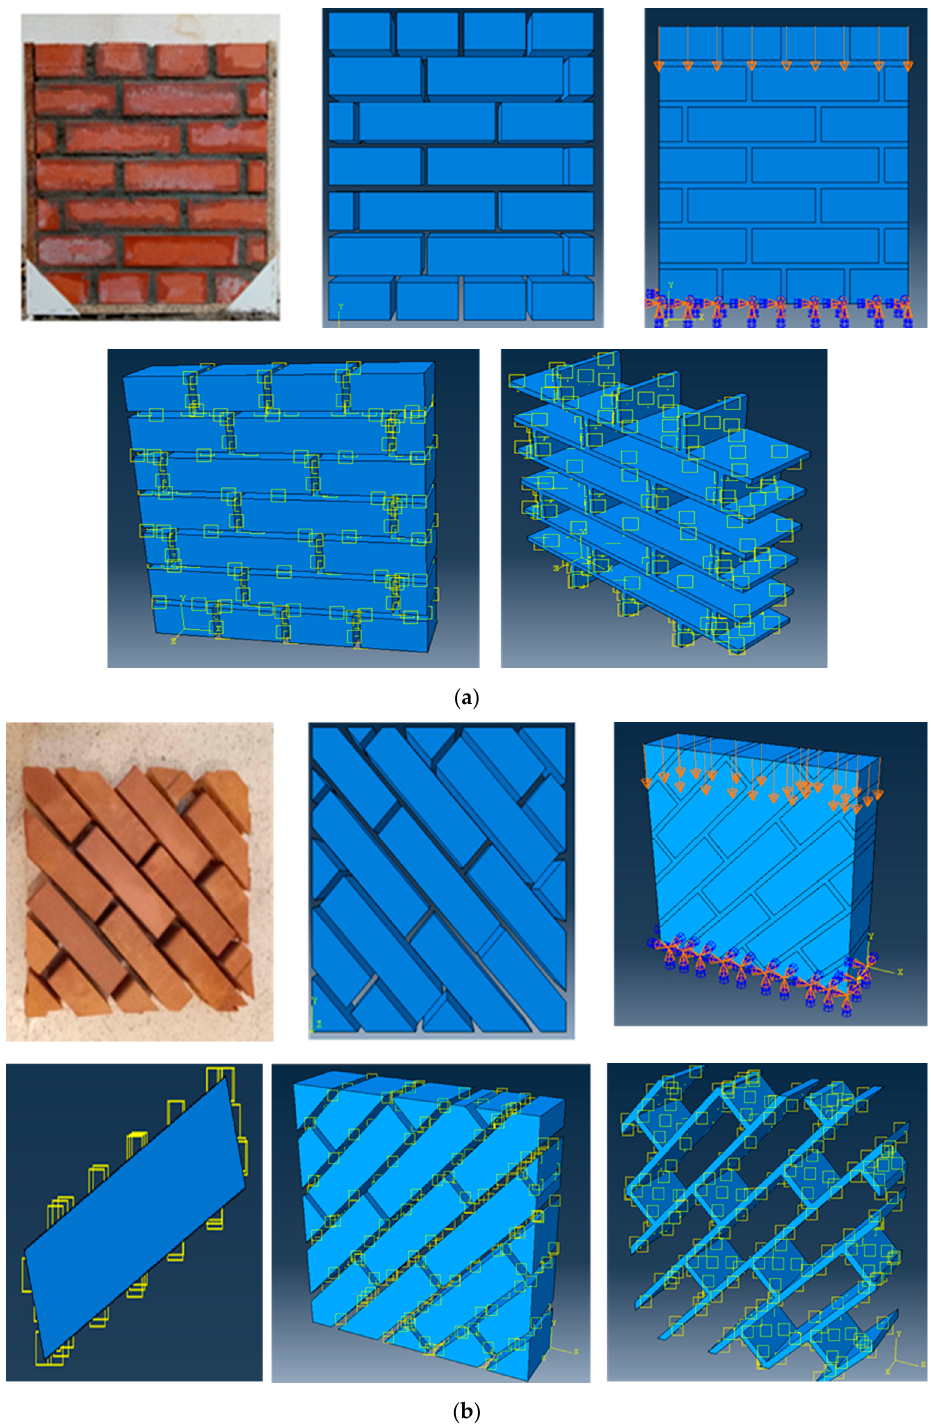
Figure 10. Numerical model (DMM), boundary conditions and interface contact of unreinforced brick masonry walls: ( a ) wall MCB ( θ = 90°); ( b ) wall MTB ( θ = 45°).